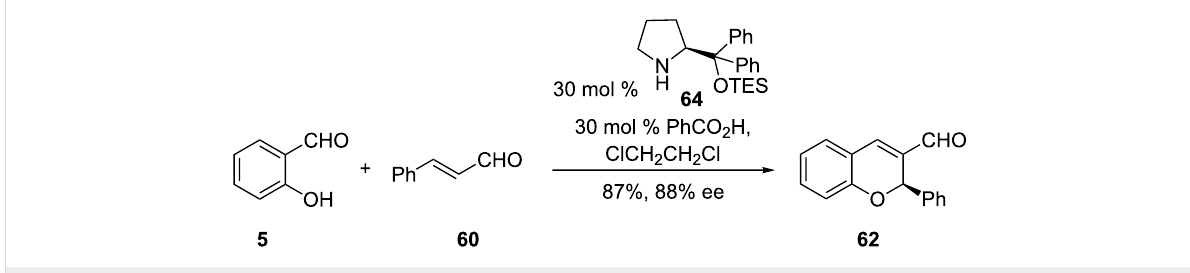
Scheme 22: Asymmetric synthesis of 2-phenylchromene 62 by Li and